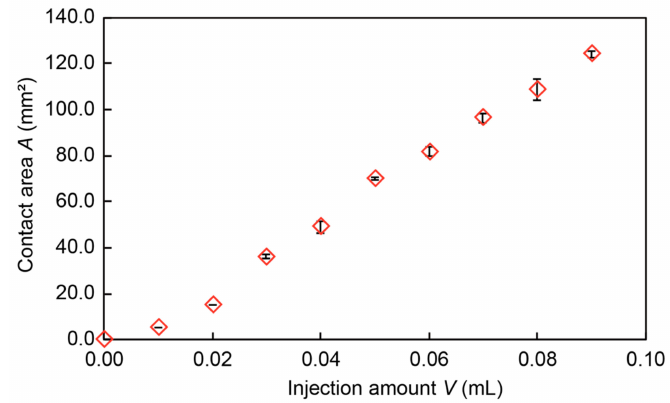
Figure 6. Measurement of the contact area.